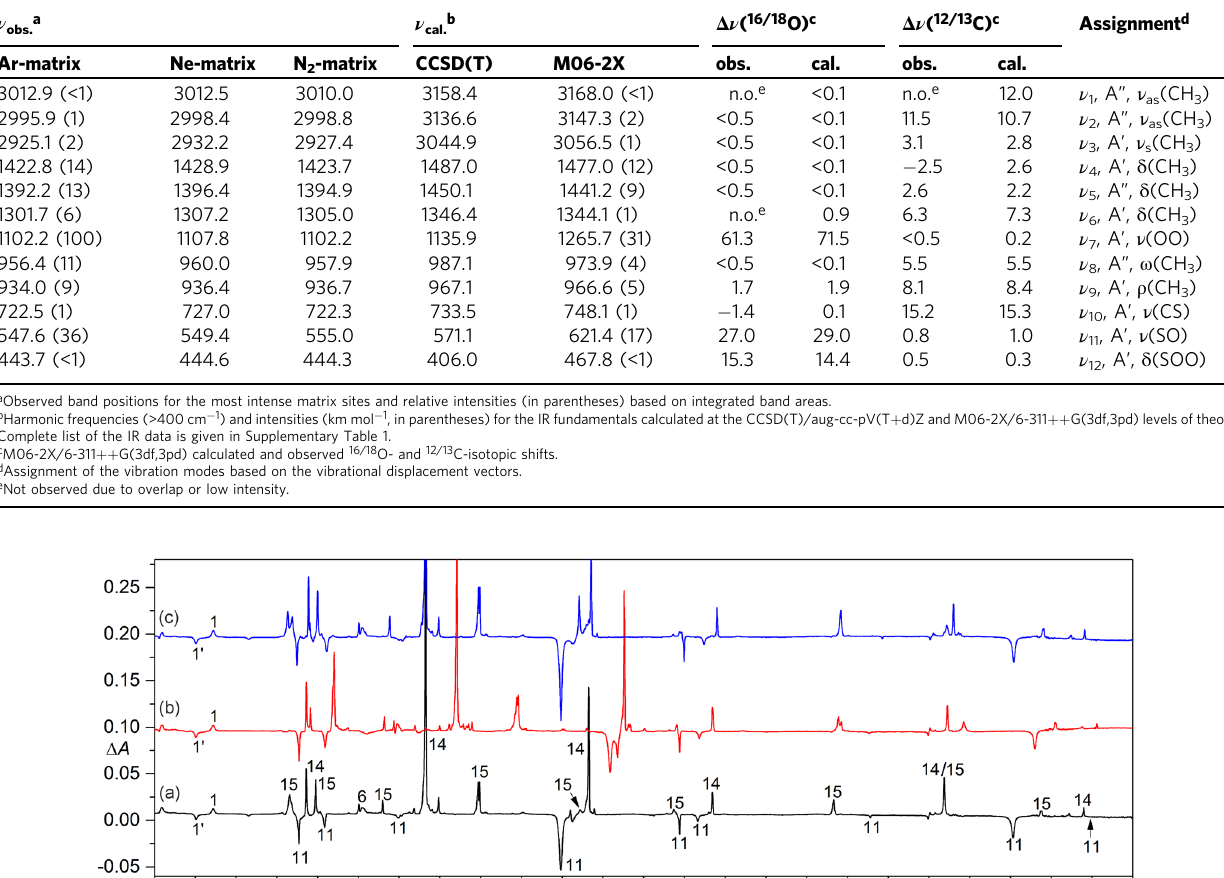
Table 1 Observed and calculated IR data (>400 cm − 1 ) for CH 3 SOO (cid:129) . ν a obs.